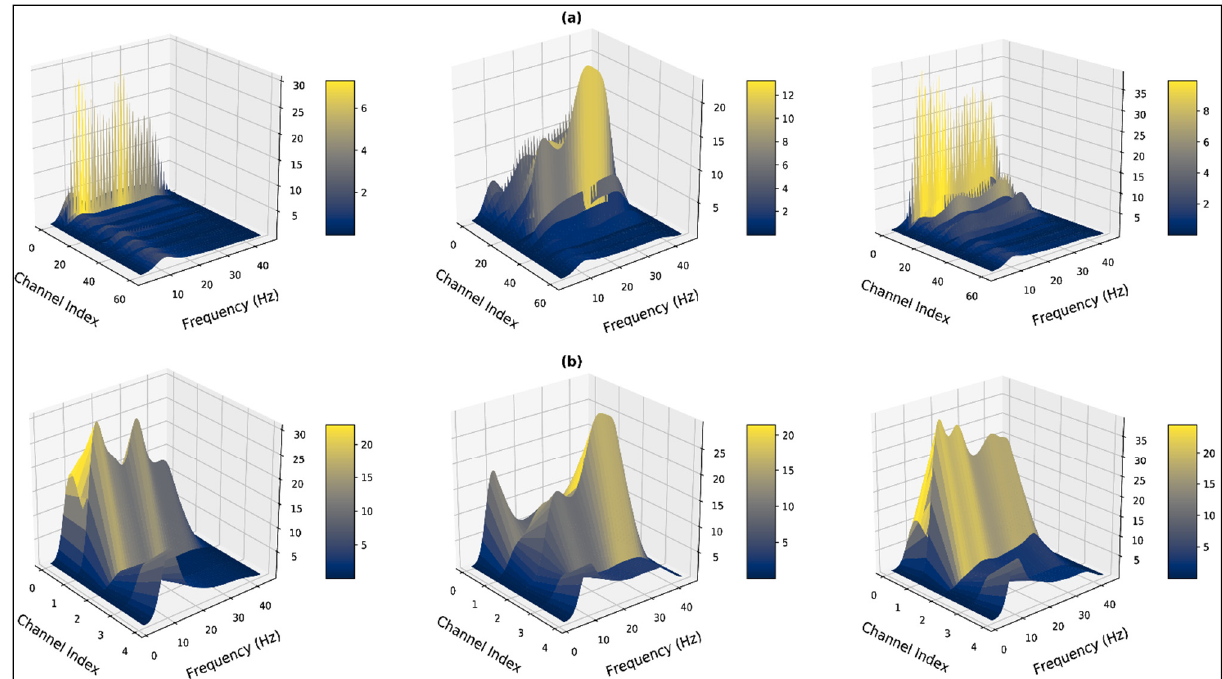
Figure 10. Three-dimensional visualization of non-parametric (Welch) spectrum for the negative state ( left ), the neutral state ( middle ), and the positive state ( right ) of subject:12, trial: 14 ( a ) considering all 62 channels ( b ) excluding the corrupt channels before channel reduction.